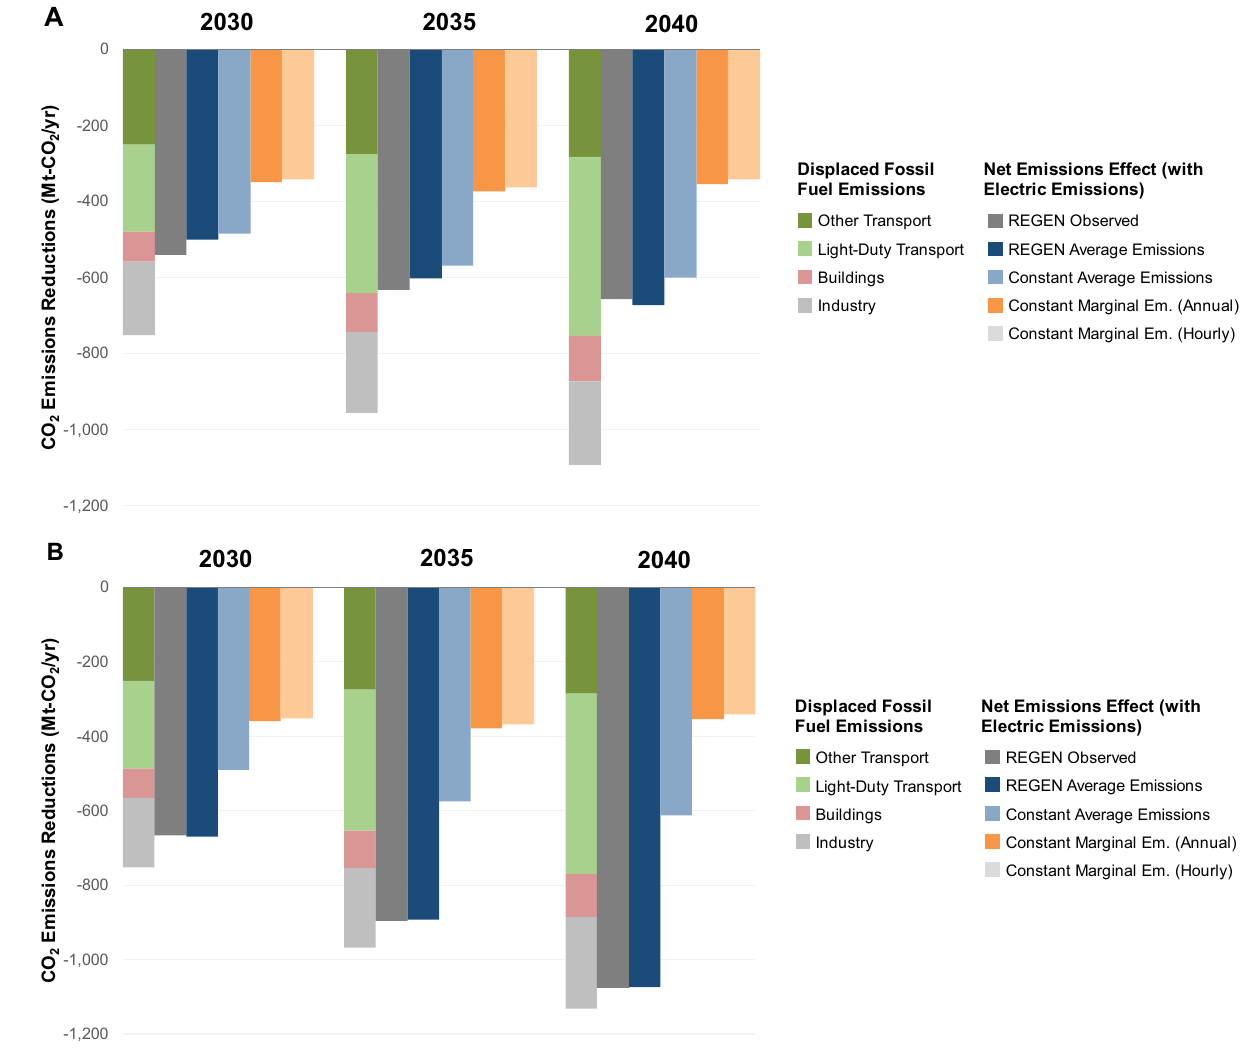
Fig.4|CO 2 emissionsreductionsfromelectri fi cationovertimeacrossdifferent approachesforaccountingforelectric sector emissions. Scenariosassume high electri fi cation with current policies ( A ) and economy-wide carbon tax ( B ). Stacked bars show displaced fossil fuel emissions by sector. The other bars show the net